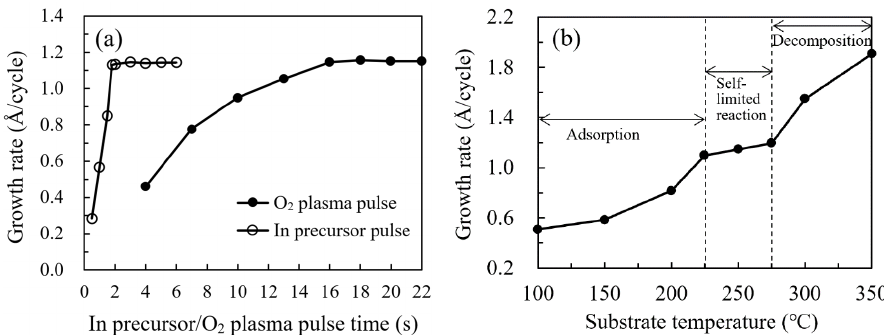
Figure 3. ( a ) Change in the growth rate of In 2 O 3 films with the In precursor and O 2 plasma pulse time; and ( b ) the growth rate of In 2 O 3 films on a silicon wafer as a function of substrate tempera- ture.